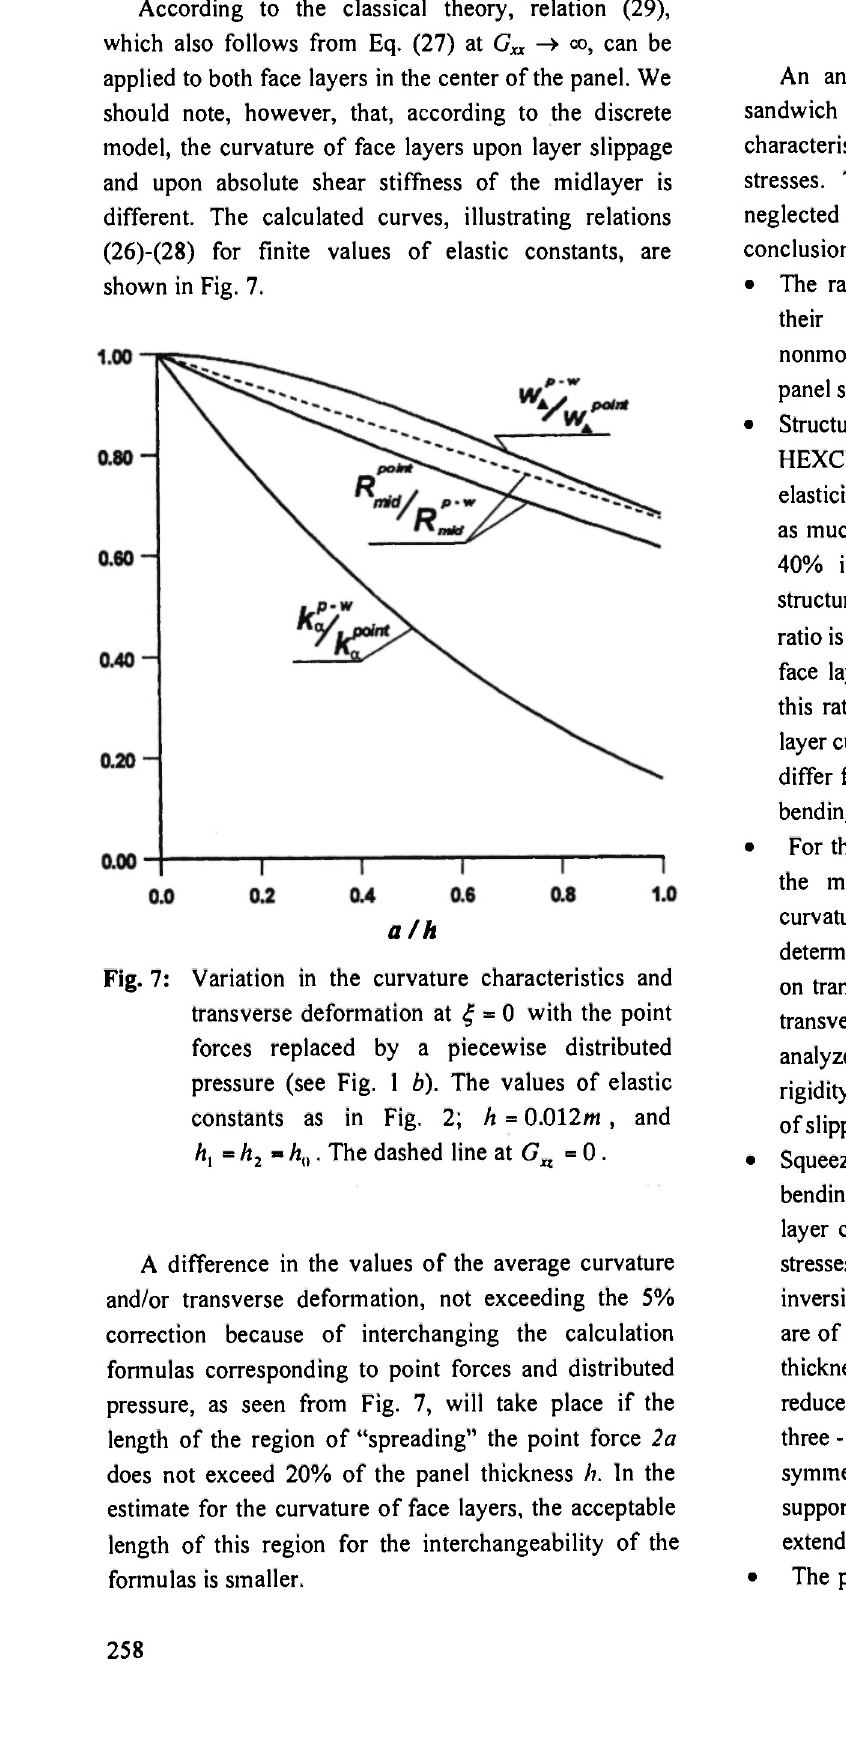
and/or transverse deformation, not exceeding the 5% correction because of interchanging the calculation pressure, as seen from Fig. 7, will take place if the